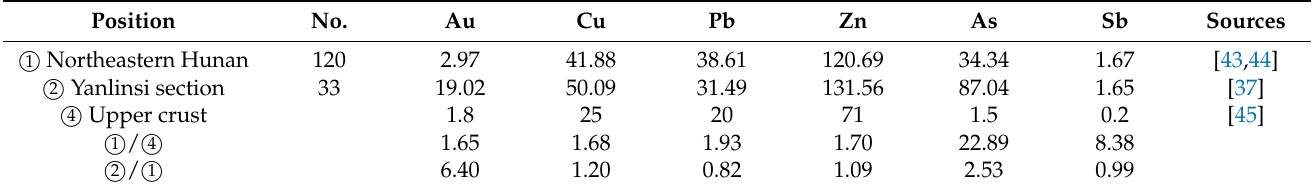
Table 5. Abundance and parameters of some metallic elements in the Lengjiaxi Group and Xiaojiashan gold deposit in northeastern Hunan ( ω (B)/ppm, ω